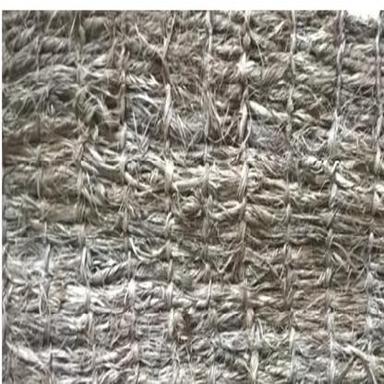
mp Fiber Mat Fig.4 Sugar Tree Fiber Mat